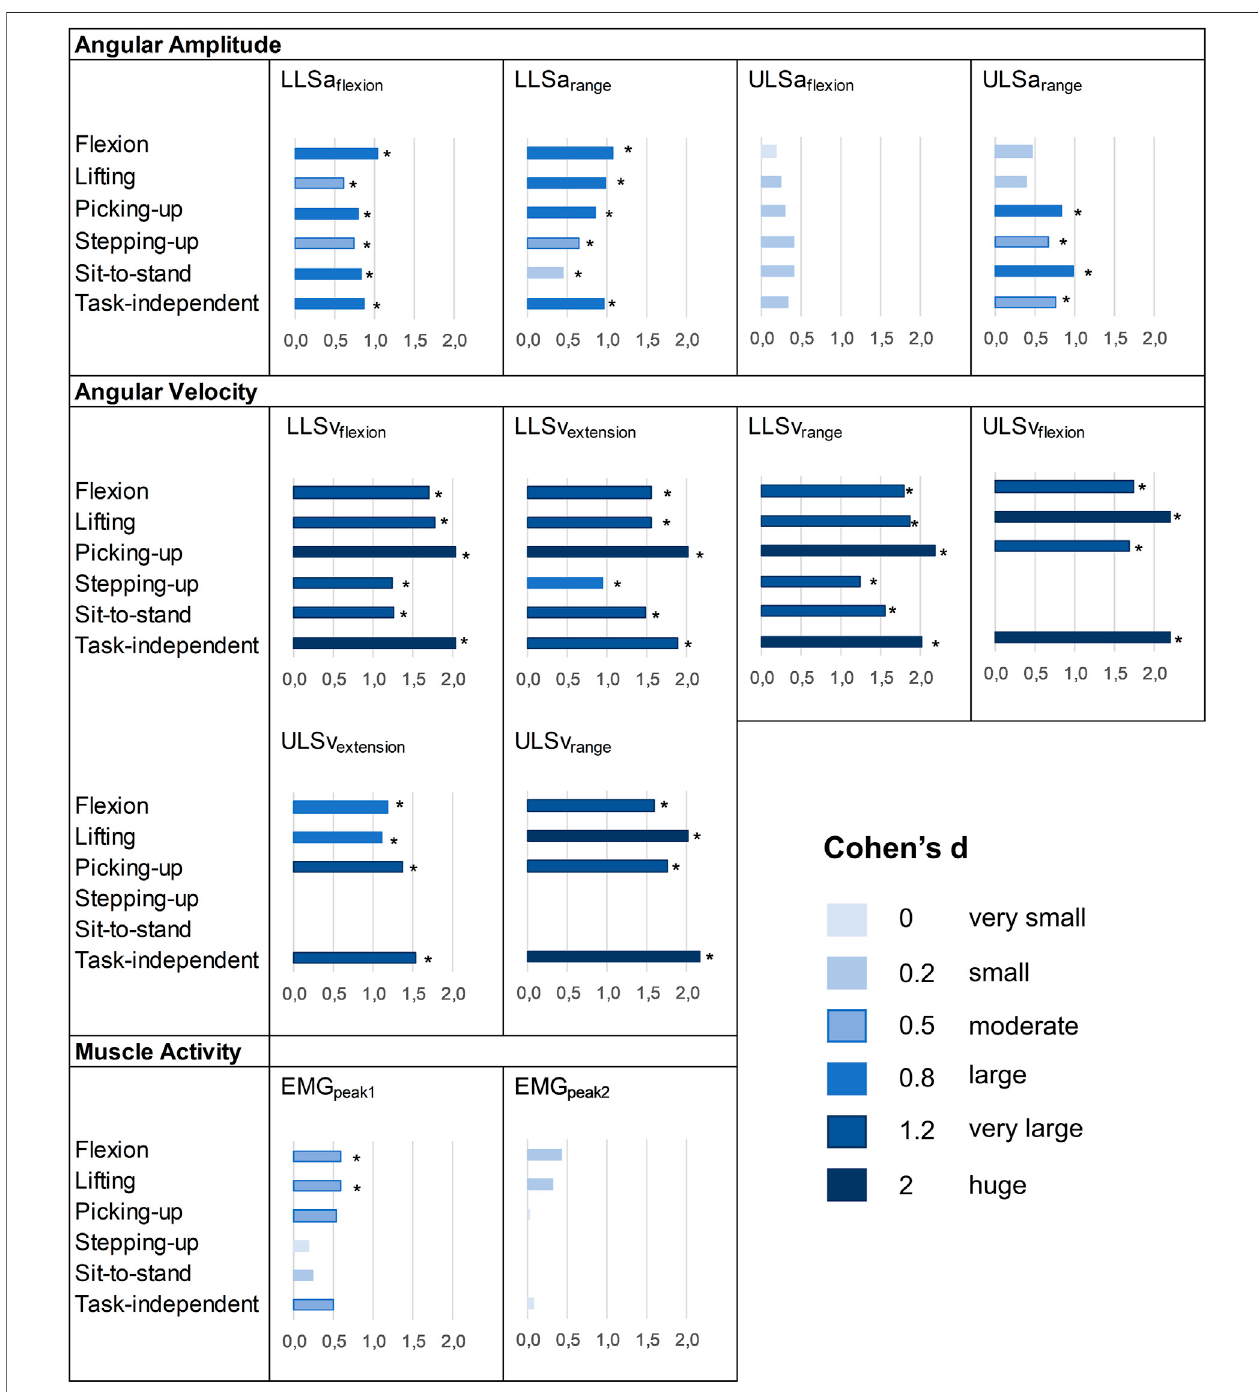
FIGURE 3 | Effect sizes of the differences between patients with CLBP and asymptomatic controls. *: p-value < 0.05 at t-tests. No ES means that the variable was not available because there was no characteristic pattern (see Data processing).